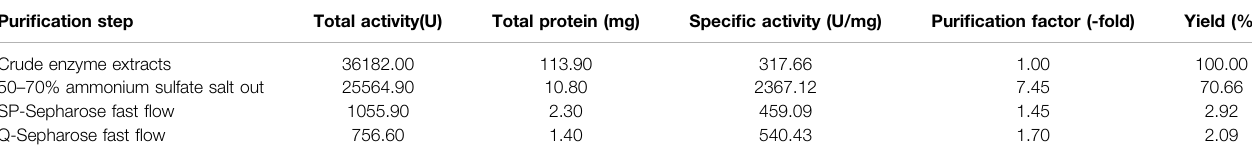
TABLE 1 | Summary of xylanase puri fi cation from Penicillium janthinellum XAF01. Puri fi cation step